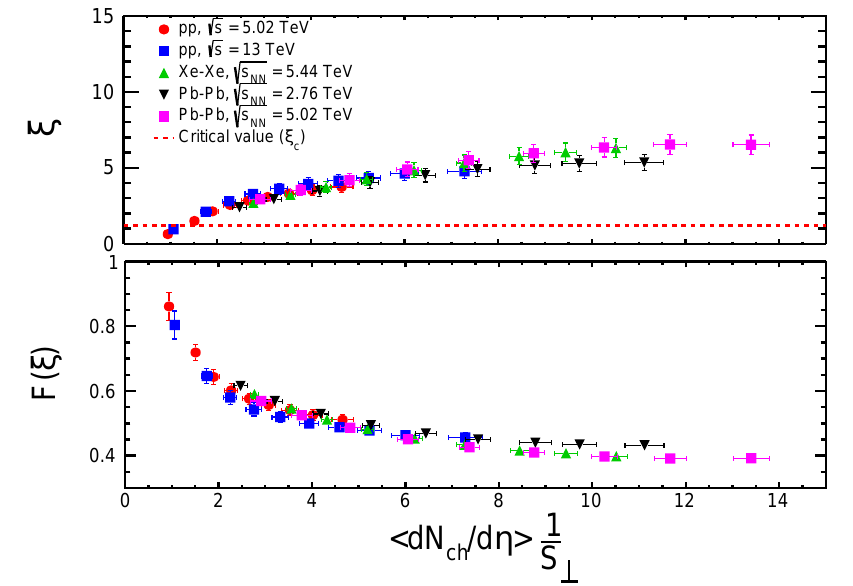
Figure 1. Percolation density parameter, ξ ( upper panel ), and color suppression factor, F ( ξ ) ( bottom panel ), as functions of charged particle multiplicity (the pseudorapidity density at midrapidity) within | η | < 0.8 scaled with the transverse overlap area S ⊥ in pp , Xe-Xe and Pb-Pb collisions. For pp collisions, multiplicity-dependent S ⊥ is obtained from IP-Glasma model [89]. In case of Xe-Xe and Pb-Pb collisions, S ⊥ values are obtained using the Glauber model [90]. See text for